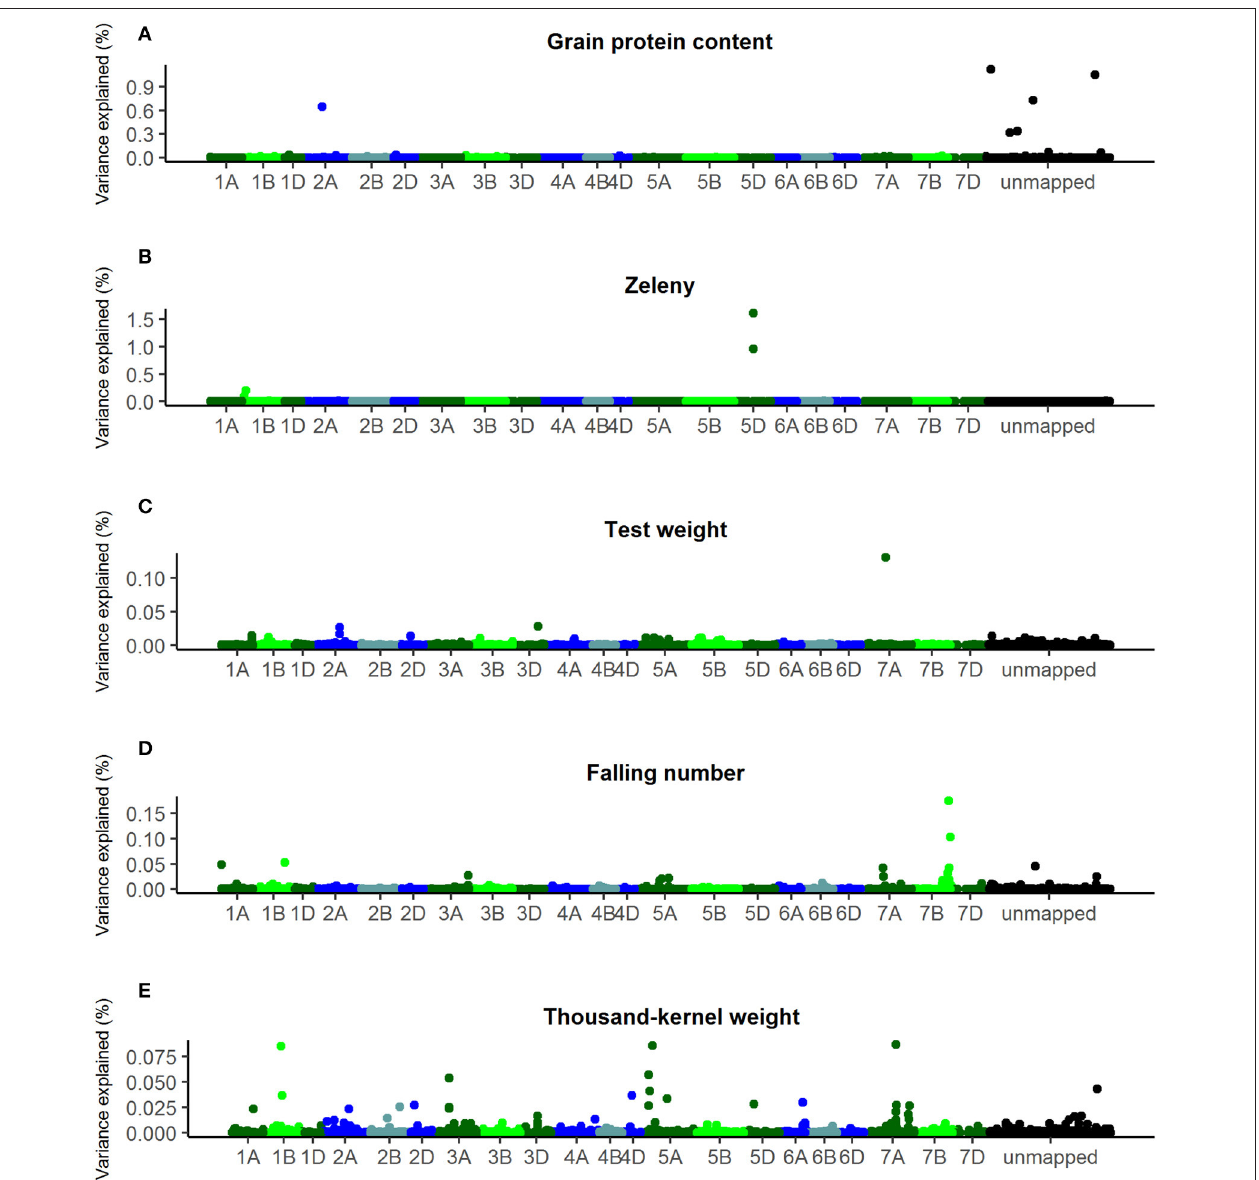
FIGURE 6 | Percentage of additive genetic variance explained by the SNPs according to the Bayesian Power Lasso analyses. (A) Grain protein content, (B) Zeleny, (C) test weight, (D) falling number, (E) thousand-kernel weight. Last bin is unmapped